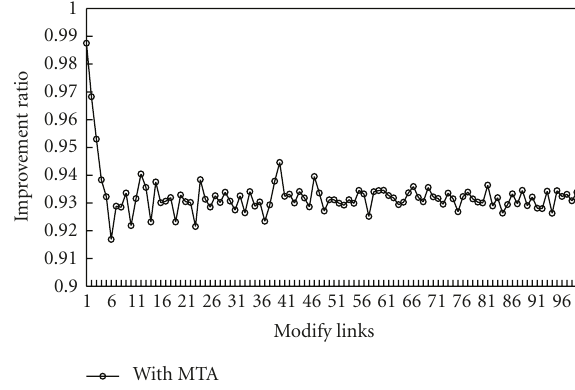
Figure 7: The Improvement Percentage using MTA Procedure (1– 100 links).